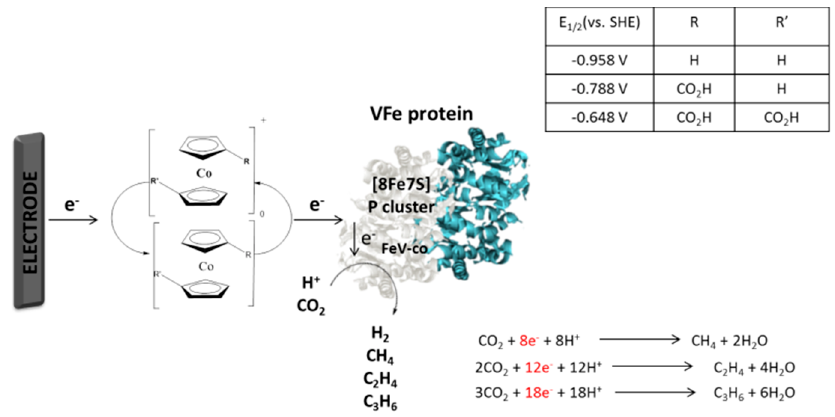
Figure 16. A schematic of C–C bond preparation via bioelectrocatalysts, Amperometric i − t trace carried out for enzymatic electroreduction of CO 2 via VFe nitrogenase [191] .